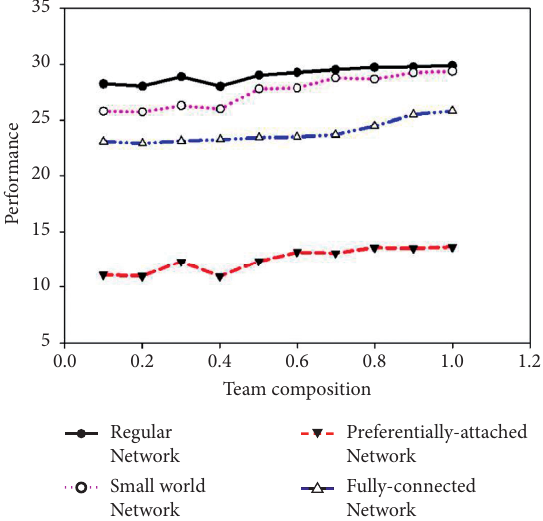
Figure 8: Final performance level of different team